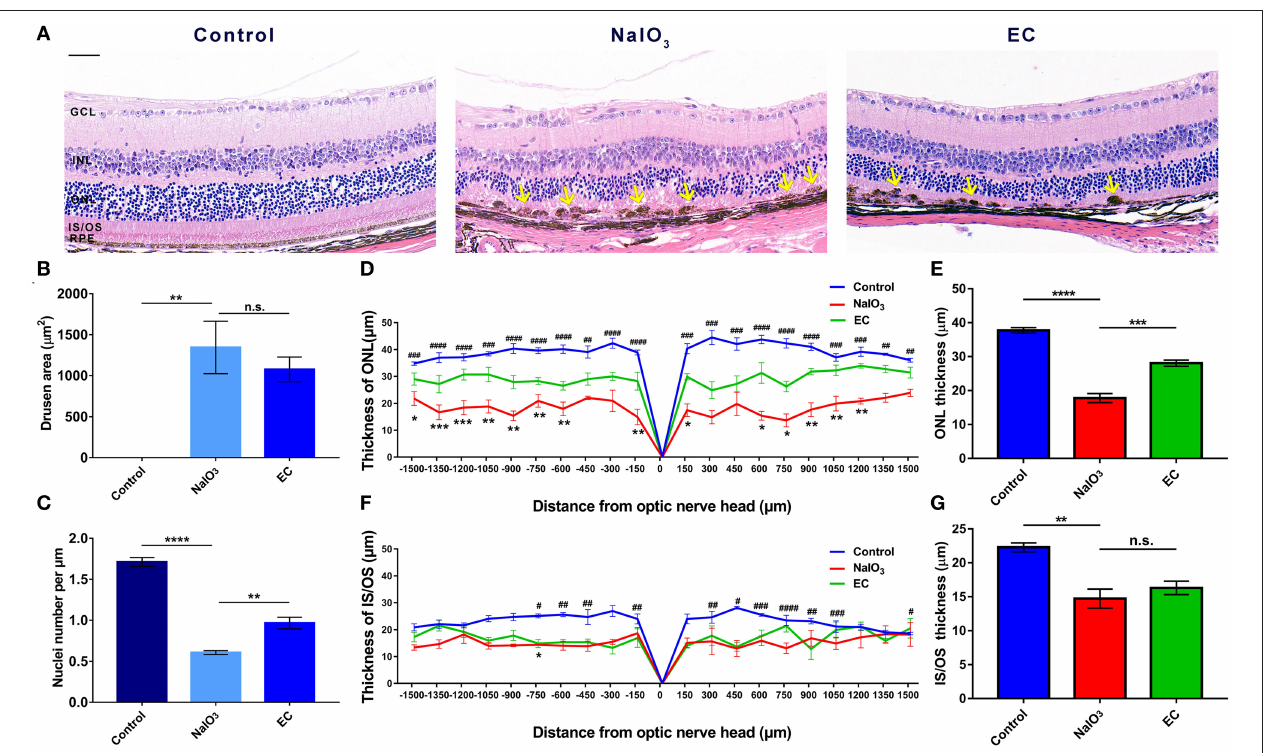
FIGURE 2 | EC protects against retinal degeneration caused by NaIO 3 administration. (A) The ONL underwent deformation by day 7 after NaIO3 administration, but this damage was ameliorated by EC treatment. Yellow arrows indicate drusen-like melanin deposits. (B) The total area of drusen-like deposits tended to be smaller and reduced in the EC group. (C) The number of nuclei per µ m in the ONL was significantly increased in the EC group. (D) Thickness of the ONL and (F) IS/OS layers were measured at 150 µ m intervals from the optic nerve head (#, Control vs. NaIO 3 group; *, NaIO 3 vs. EC group). (E) Mean thickness of the ONL and (G) IS/OS layers. GCL, Ganglion cell layer; INL, inner nuclear layer; ONL, outer nuclear layer; IS/OS, inner segment/outer segment; RPE, retinal pigment epithelium. Values are presented as mean with SEM, n = 4; n.s., no significance; * p < 0.05, ** p < 0.01, *** p < 0.001, **** p < 0.0001. Scale bar: 50 µ